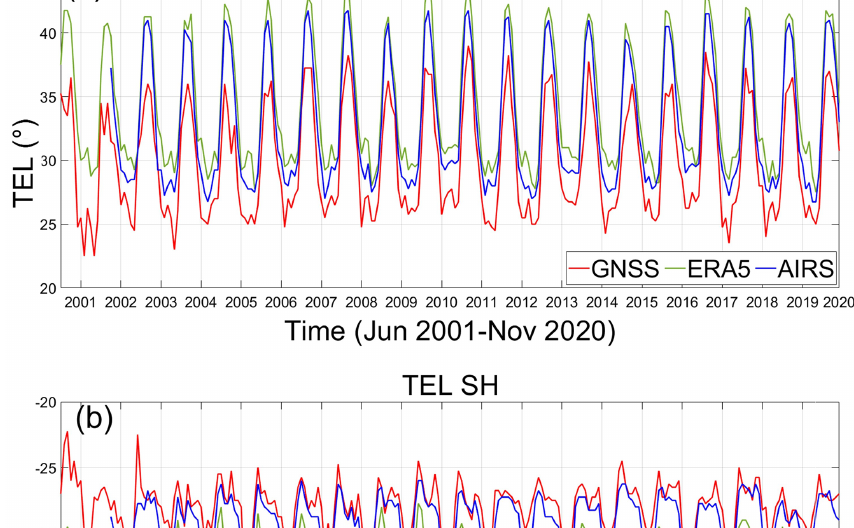
ral and spatial variability given by the first PCA